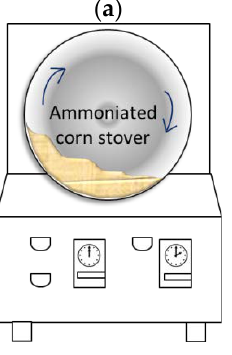
Figure 1. Tumbler mixer ( a ) and batch-type pretreatment reactor ( b ).